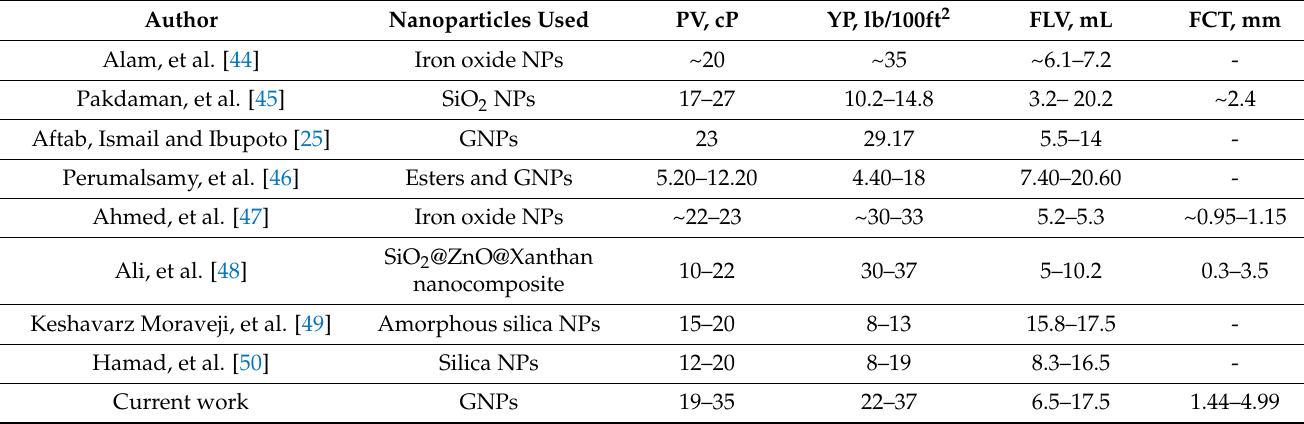
Table 4. Comparative analysis of the literature and current